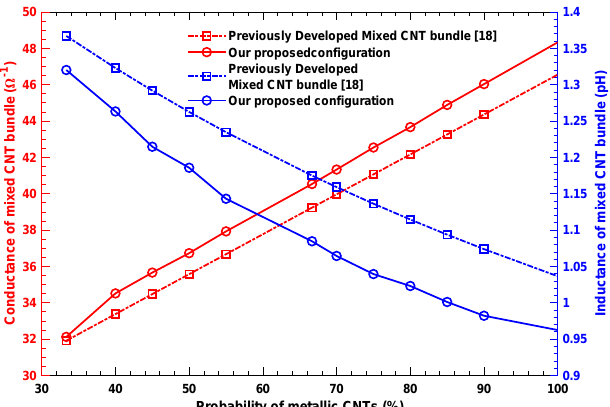
Figure 5. Impact of increasing metallic CNTs on the conductance and inductance and comparison of the results of the proposed configuration and the earlier mixed CNT bundle configuration. Overall conductance and inductance of the mixed CNT bundle is obtained, considering the interconnect length of 40 nm.